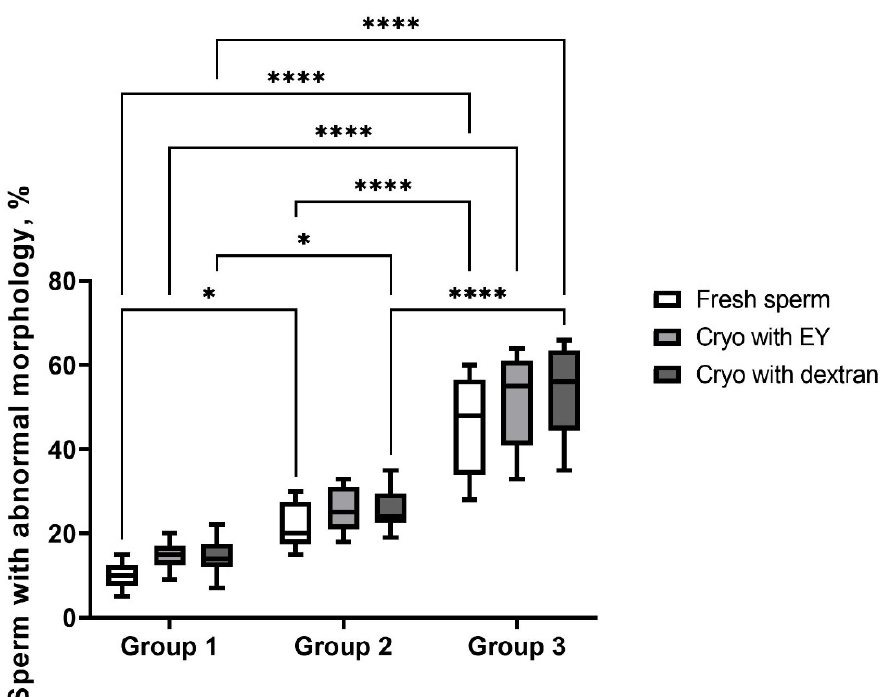
Figure 2. Morphological characteristics of spermatozoa of dogs of different ages after cryopreservation with two different extenders. *— p < 0.05, ****— p < 0.0001. Table 2. Percentage of spermatozoa with various morphological abnormalities depending on the age of the dog and the type of extender. Morphology Abnormalities Group Head,